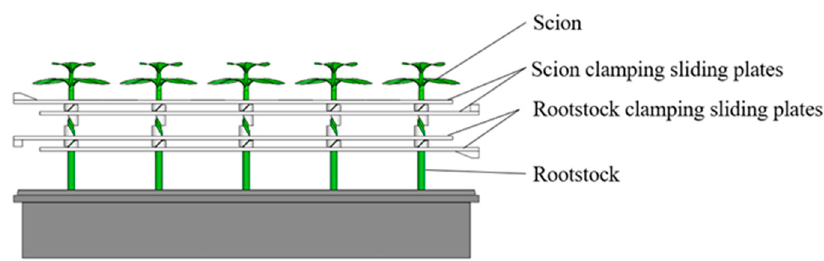
Figure 5. The rootstock and scion plug trays shifted to the left, with the scions fixed. Figure 6. Grafted plug seedlings. Figure 6. Grafted plug seedlings. Figure 6. Grafted plug seedlings.